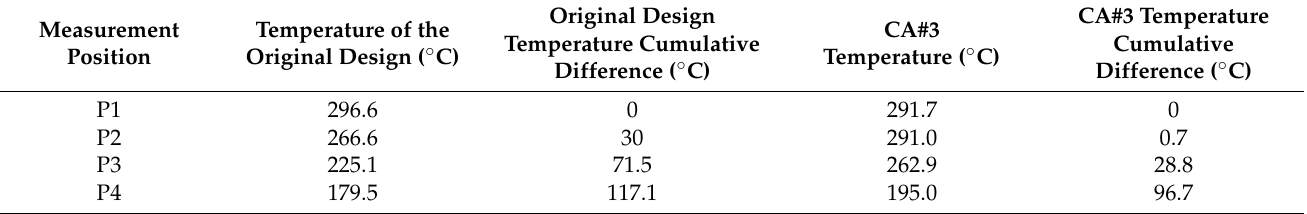
Figure 16. Temperature distribution measured by the thermal imager on the surface of the CA#3 stone grill plate. Table 3. Comparison table of temperature before and after modification of stone grill plate.